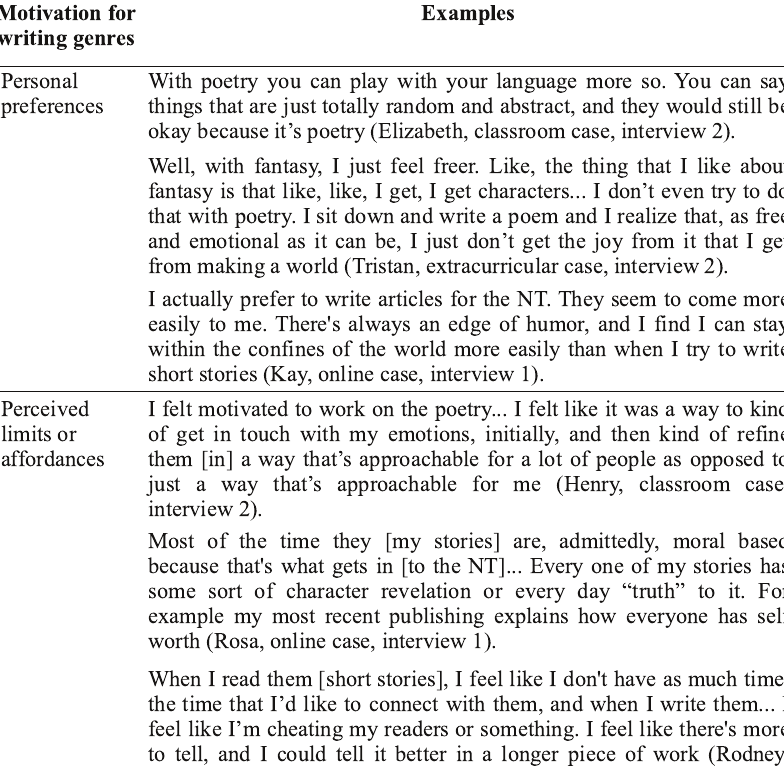
Code Examples: Cross-setting Motivations to Write